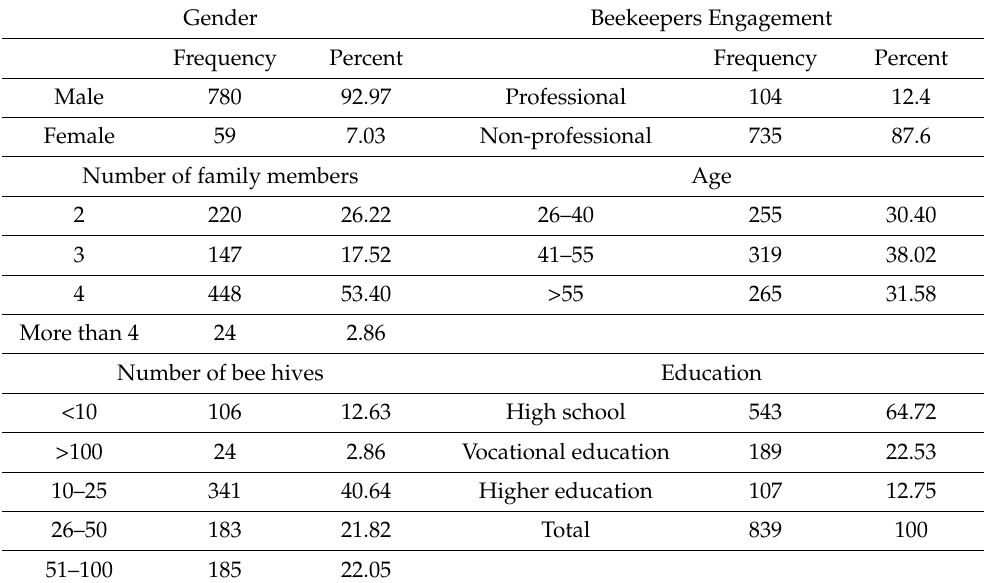
Table 1. Socio-demographic structure of the